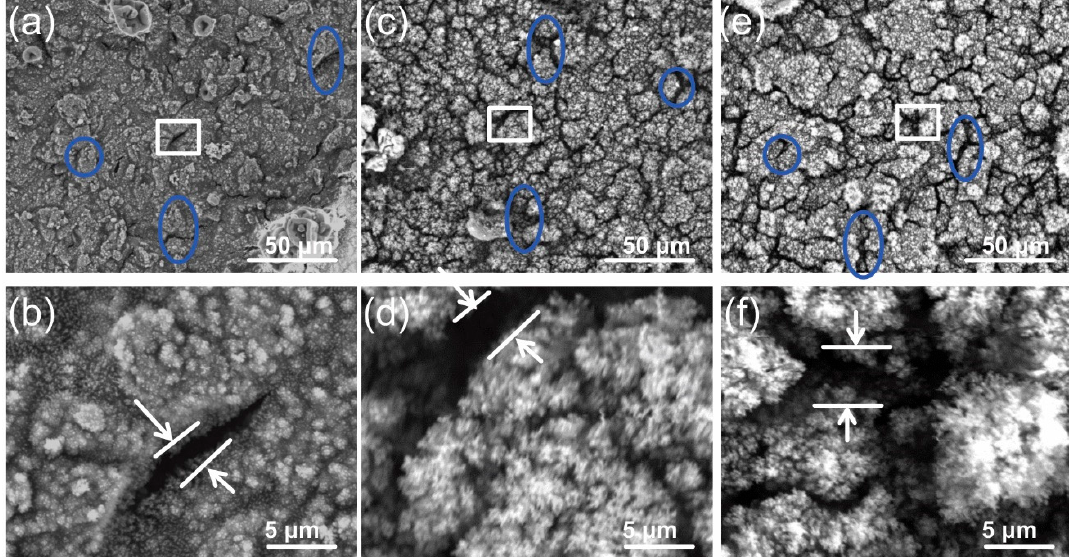
16 of 20 Figure A2. Effects of varying polyamino acid enantiomer type. ( a ) percent LIVE ® stained area of MC3T3-E1s cultured on AntiA-bCaP-PEM30-D-FGF2 (orange) as compared to cells cultured on AntiA-bCaP-PEM30-L-FGF2 (Green) (** p = 0.003, *** p <0.0004); ( b ) fluorescent LIVE ® stained images at 4 h, and one, three, and five days of culture on AntiA bCaP-PEM30-L-FGF2 as compared to cells